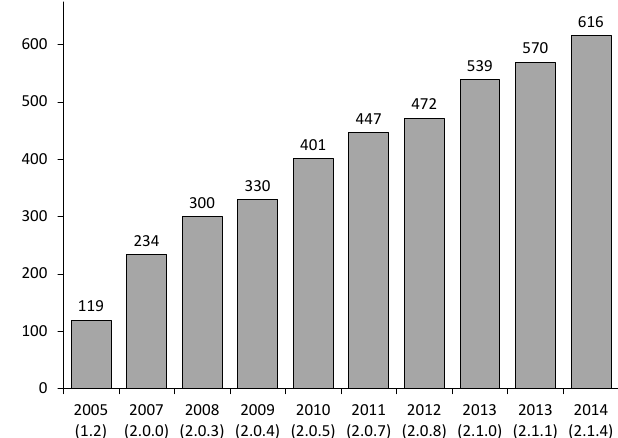
Figure 2. Number of tools between 2005 (v1.2) and 2014 (v2.1.4).